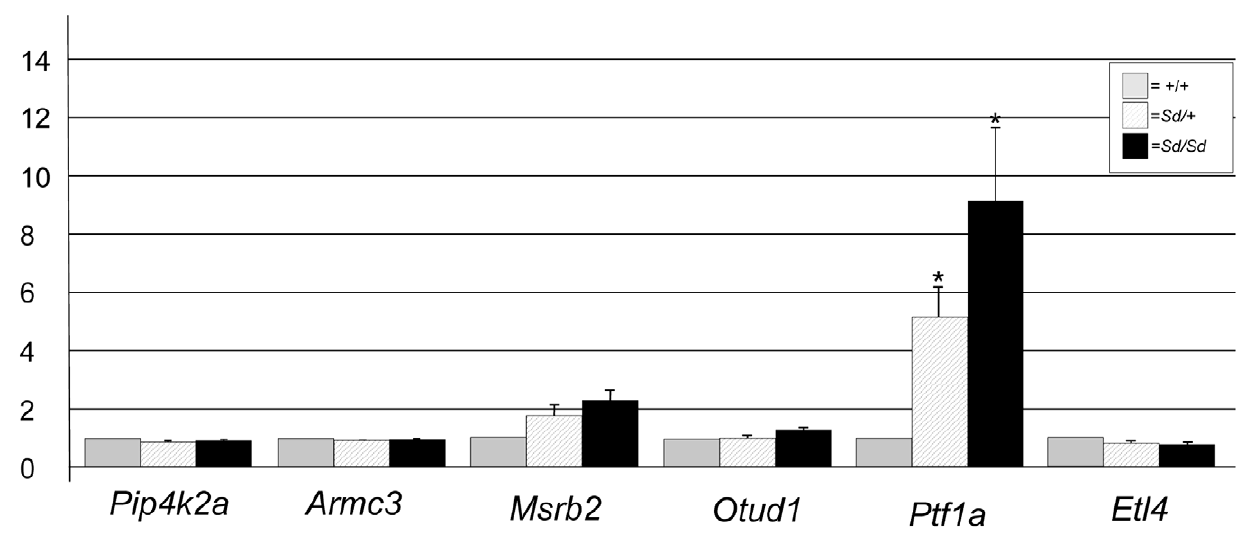
Figure 4. Gene expression at E9.5 in Sd mutant embryos. Quantitative real time PCR plot of gene expression in RNA isolated from Sd/Sd (black bars), Sd/ + (hatched bars), and + / + (grey bars) embryos of RefSeq genes mapping to the Sd interval. Y-axis shows fold change normalized to 1 for wildtype ( + / + ) expression. * denotes significance in expression levels where p , 0.05 (For Ptf1a ; Sd / + versus + / + p=0.029, Sd/Sd versus + / + p=0.044).